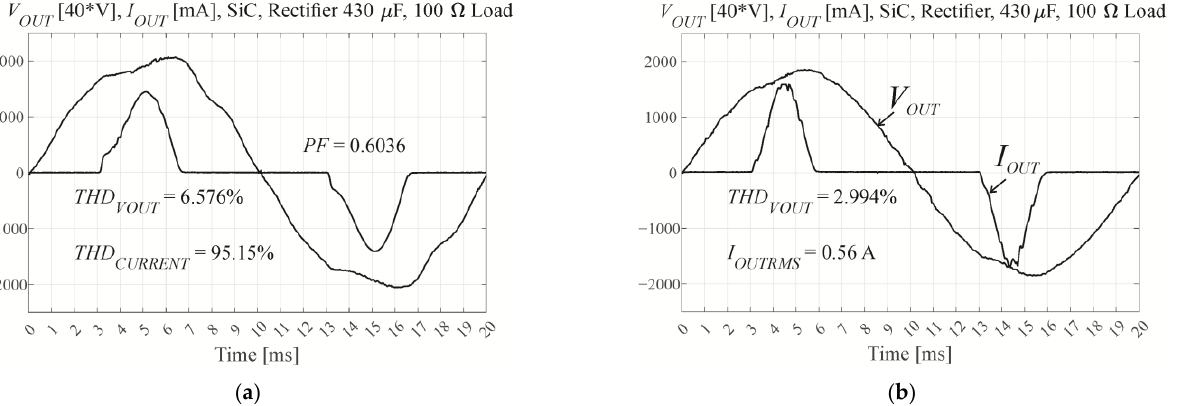
Figure 13. The VSI output voltage and current when using the nonlinear rectifier RC load (PF = 0.6) for ( a ) open-loop control and ( b ) CDM control ( τ = 8) with SiC bridge transistors and the Super MSS coil core material.